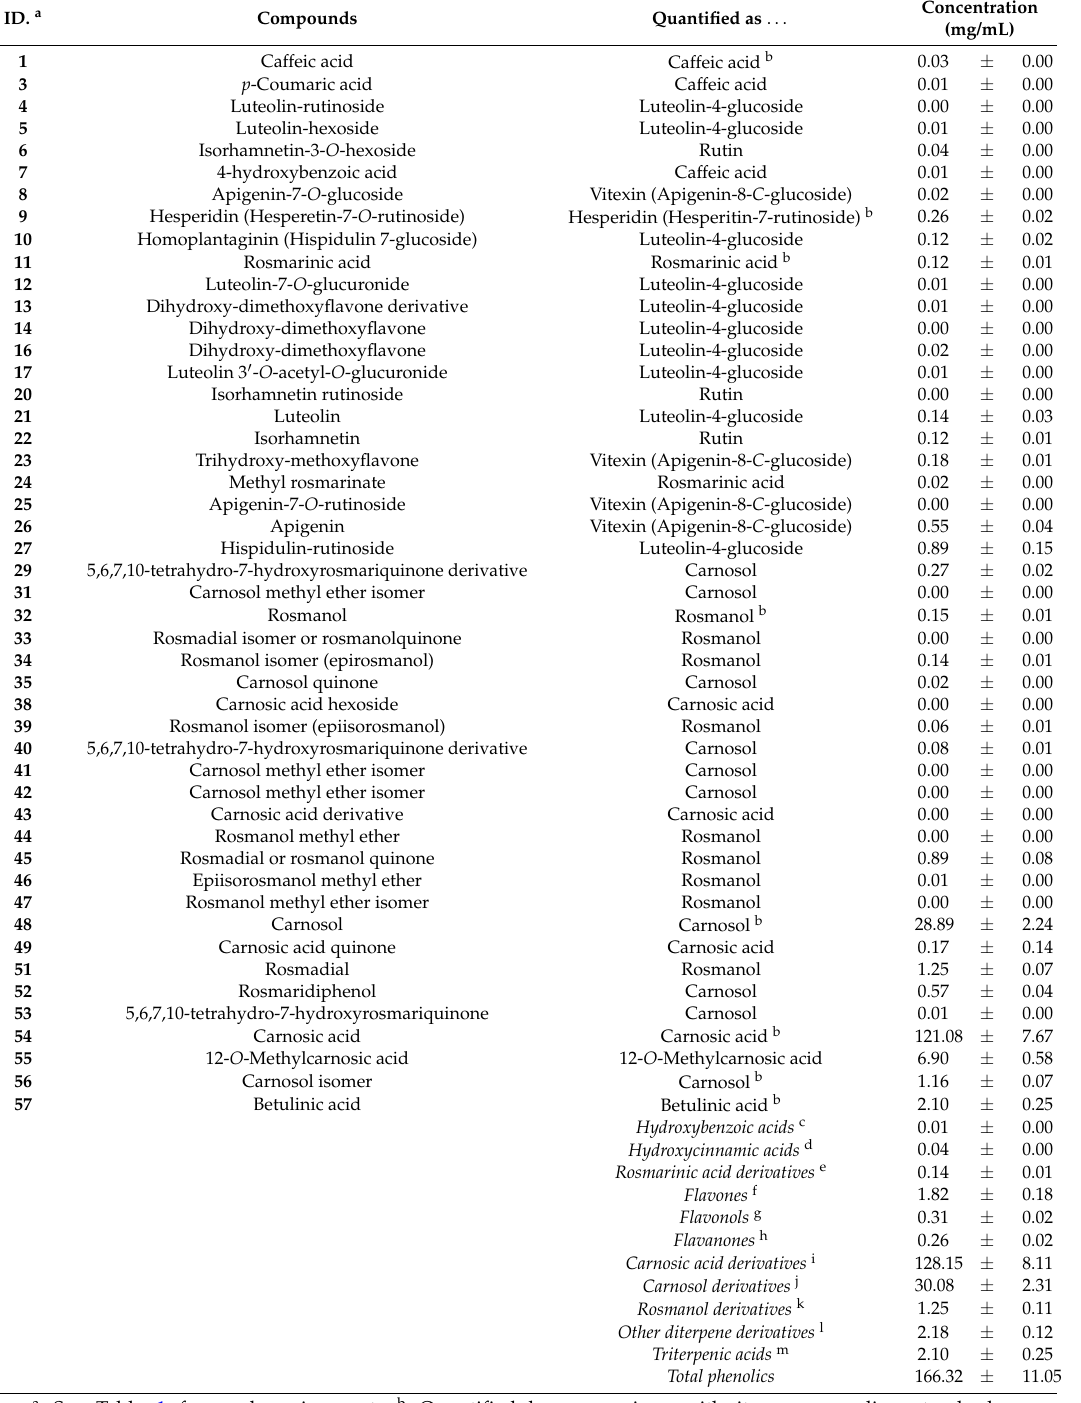
Table 2. Quantitative results for rosemary extract (poly)phenolic